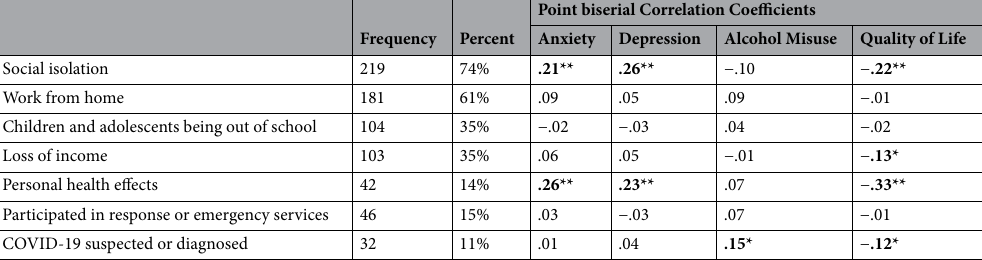
Table 1. Frequency, Percentages and Correlation Coefficients on COVID-19 Experiences. Significant values are in